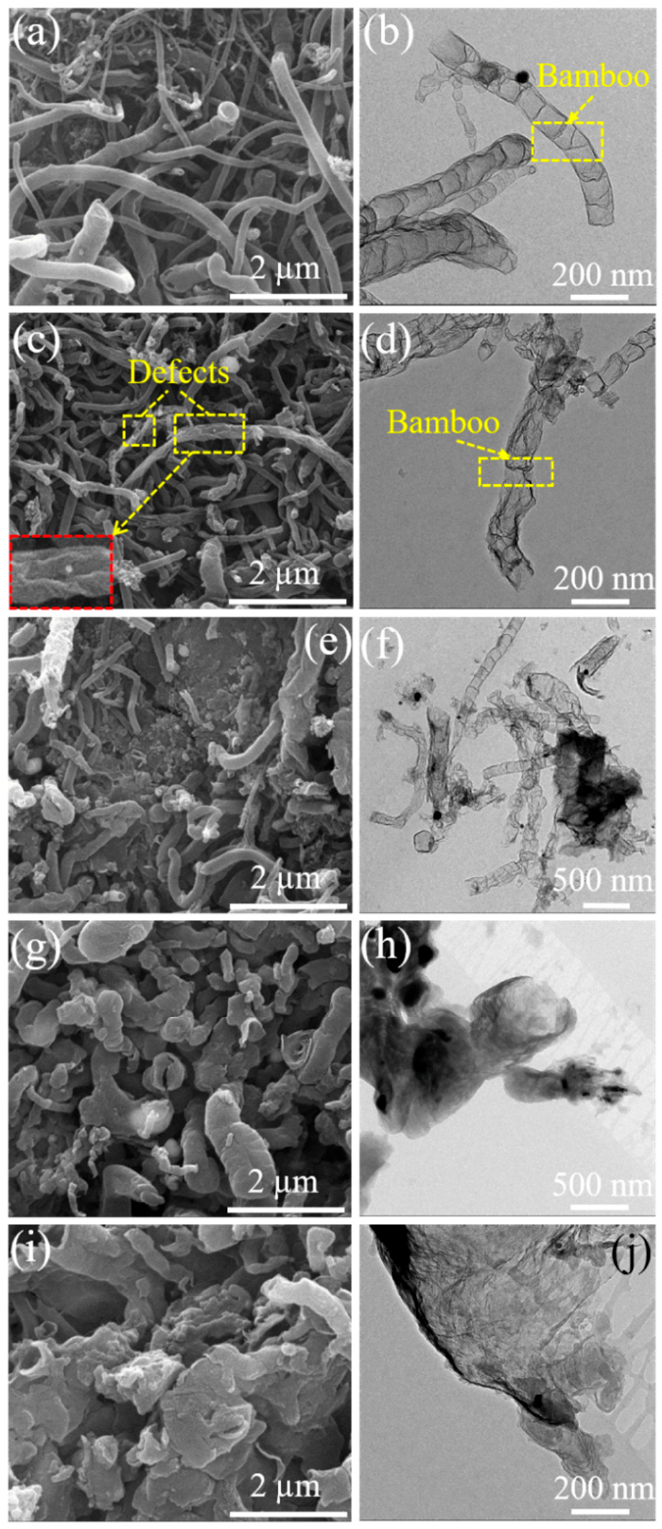
Figure 1. SEM and TEM images of B,N-CNT-1 ( a , b ), B,N-CNT-2 ( c , d ), B,N-CNT-3 ( e , f ), B,N-CNT-4 ( g , h ), and B,N-CNT-5 ( i , j ).